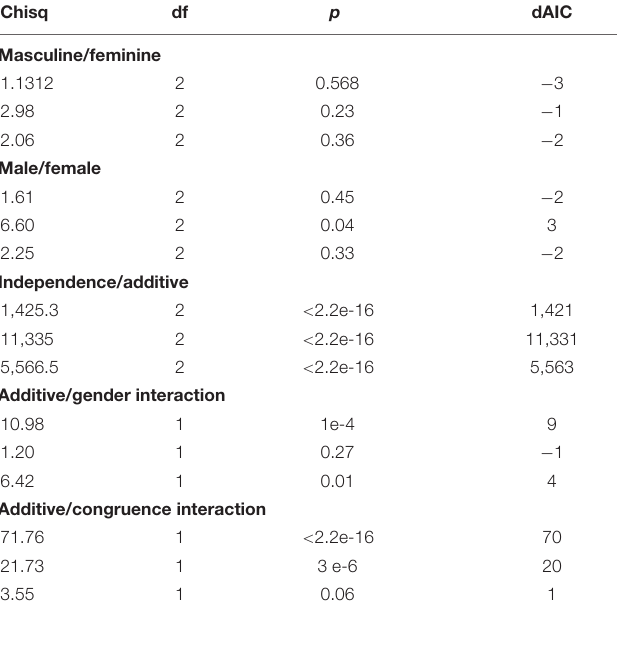
TABLE 1 | Model comparison for psychophysical